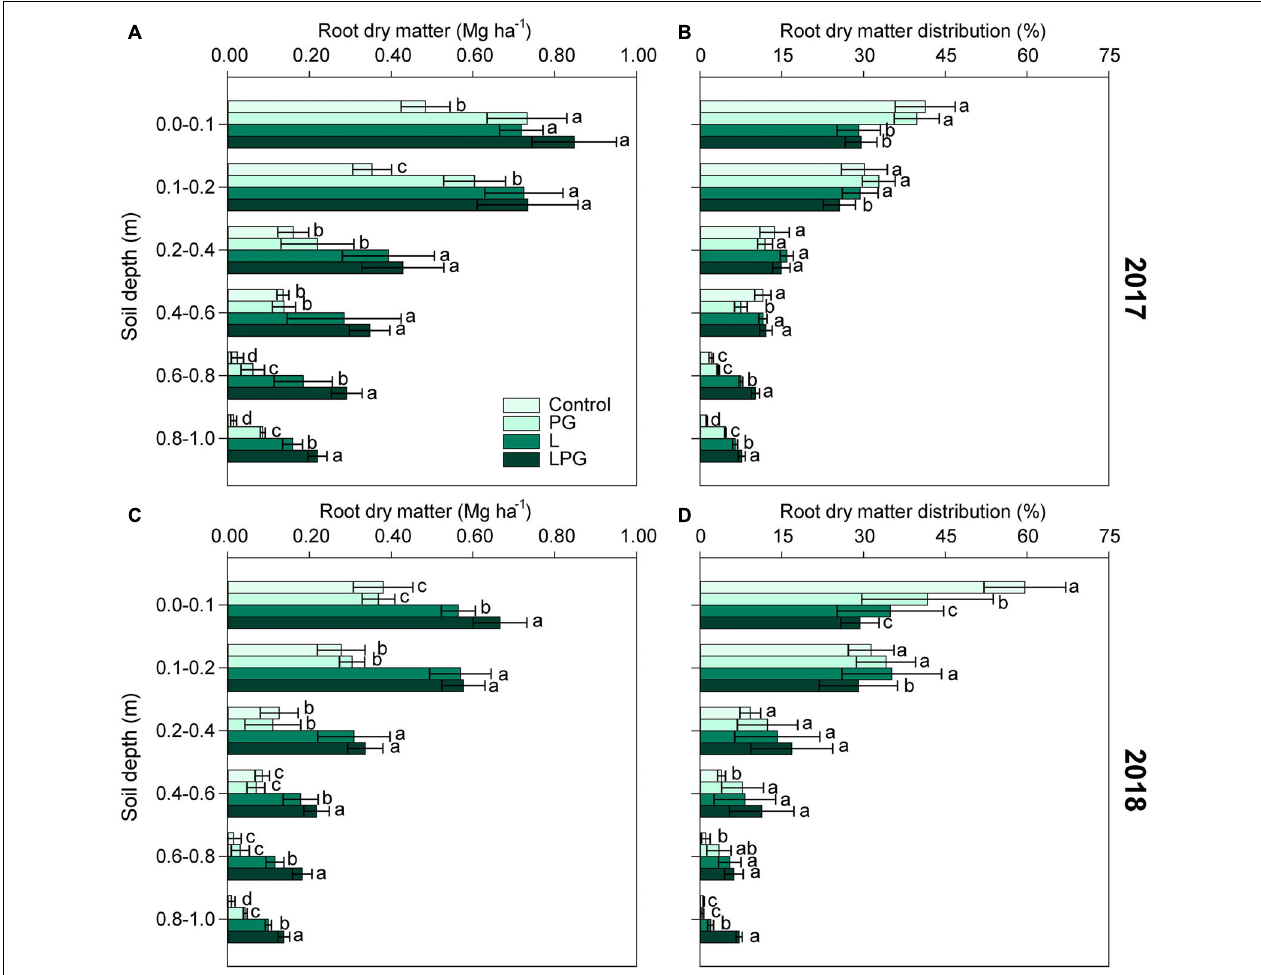
FIGURE 4 | Root dry matter (A,C) and root dry matter distribution (B,D) in the soil profile as affected by surface-applied lime (L), phosphogypsum (PG), and lime + phosphogypsum (LPG) treatments. Different lower-case letters for each soil depth indicate significant differences between treatments for each growing season by Student’s t -test at p ≤ 0.05. Error bars express the standard error of the mean ( n =